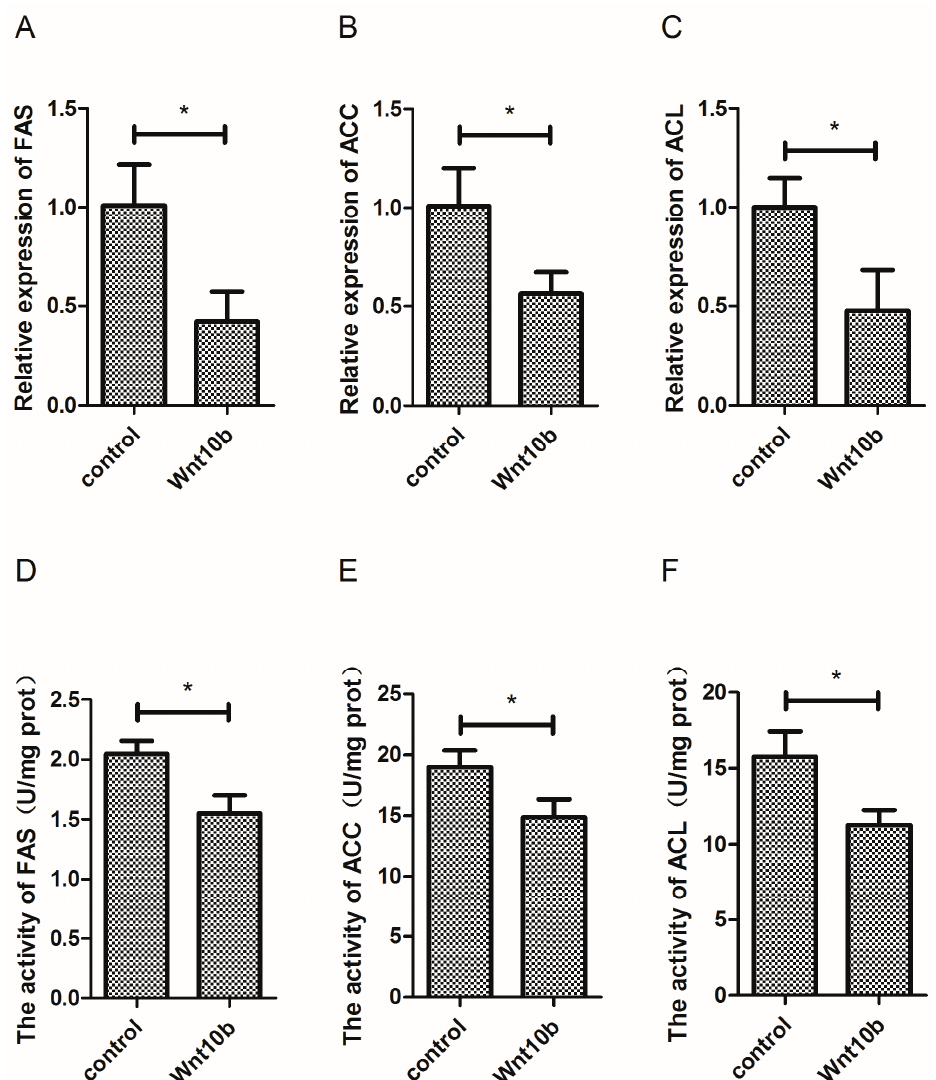
Figure 3. E ff ect of Wnt10b gene overexpression on the mRNA expression and activity of Fatty Acid Synthetase (FAS), Acetyl-CoA Carboxylase (ACC), and ATP-Citrate Lyase (ACL) in the muscle of zebrafish. ( A ) The mRNA expression of FAS; ( B ) The mRNA expression of ACC; ( C ) The mRNA expression of ACL; ( D ) The activity of FAS; ( E ) The activity of ACC; ( F ) The activity of ACL. Values are expressed as means ± s.e.m. ( n = 4). Statistically significant di ff erences are denoted by an asterisk (* p < 0.05).